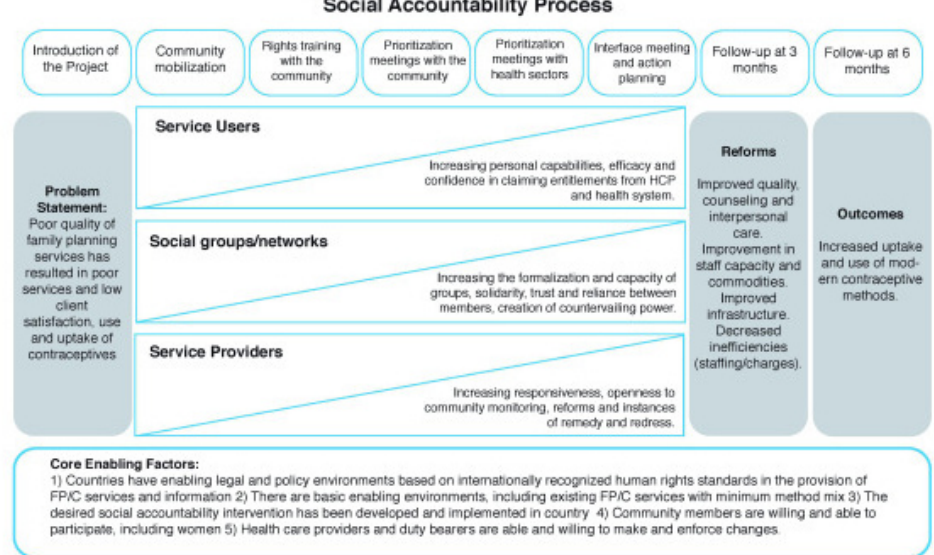
Figure 1. CaPSAI Theory of Change (This figure has been reproduced with permission from Steyn et al. ,